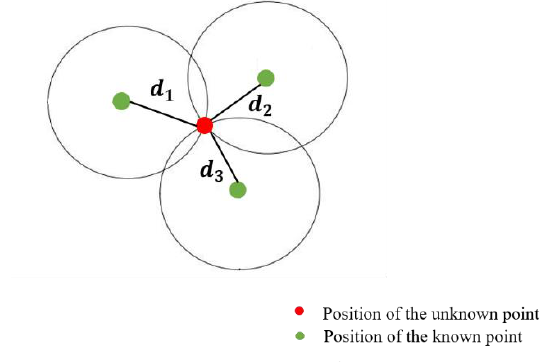
Figure7. The concept of the trilateration